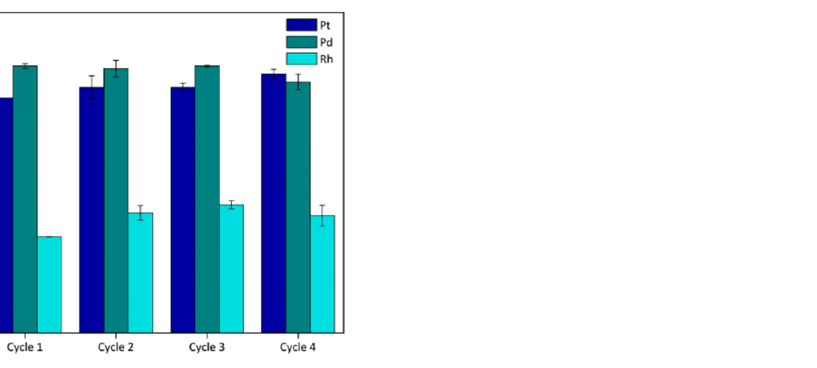
Figure 7. Extraction (%) of PGMs to P 66614 Cl and DES recovery (%) in recycling process.